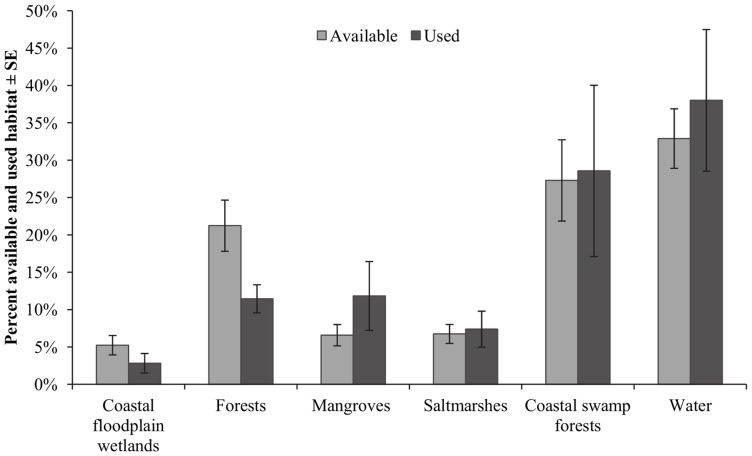
Habitat availability and use in March 2010.Percentage of available and used habitat in March 2010.